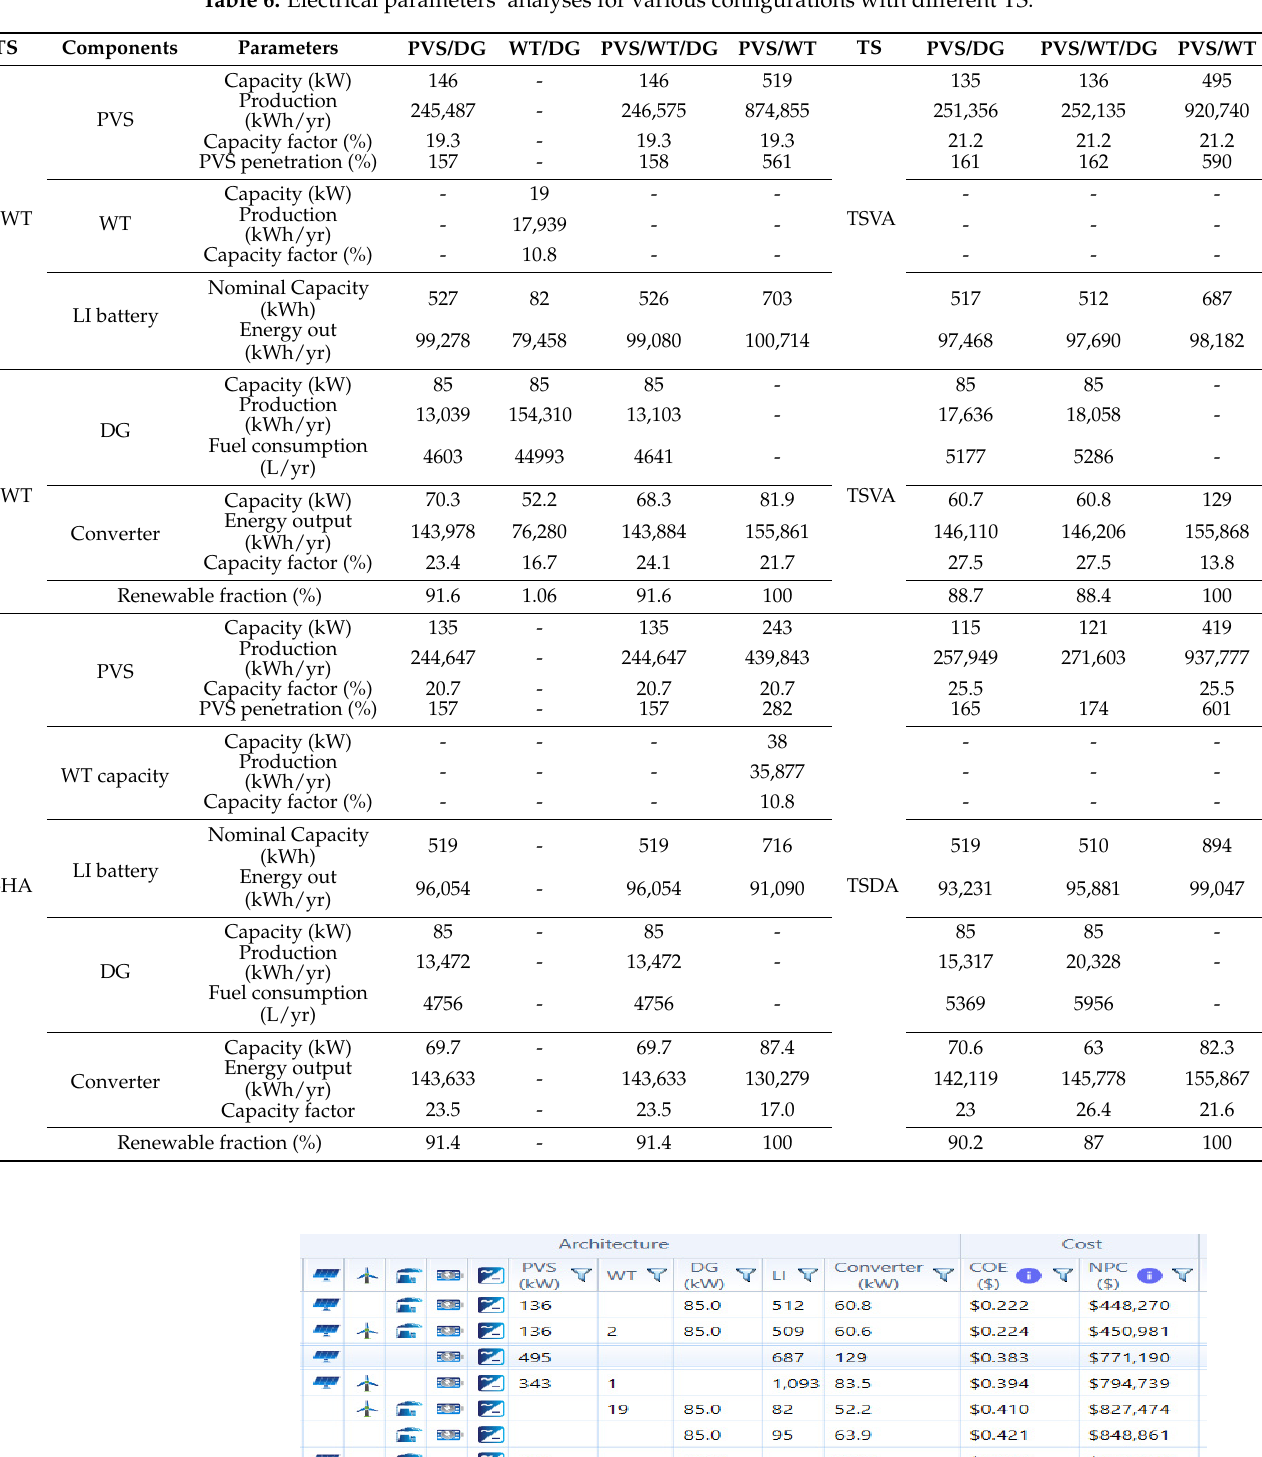
Table 6. Electrical parameters’ analyses for various configurations with different TS.